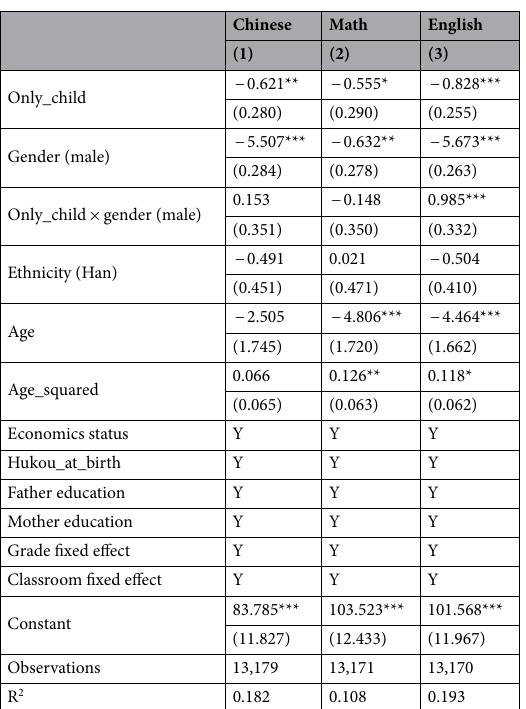
Table 3. Heterogeneity analysis: only children’s gender. Notes: Standard errors in parentheses, adjusted for within-classroom clustering. * p < 0.10. ** p < 0.05. *** p < 0.01.